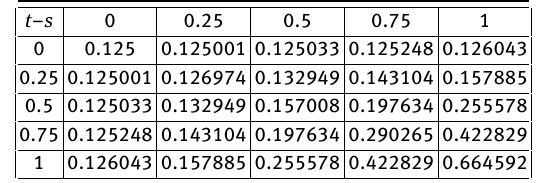
Table 12: Approximation of C ov[ X ( t ), X ( s )] via adapted gPC with p = 3 . Example 4.3, assuming independent random data.